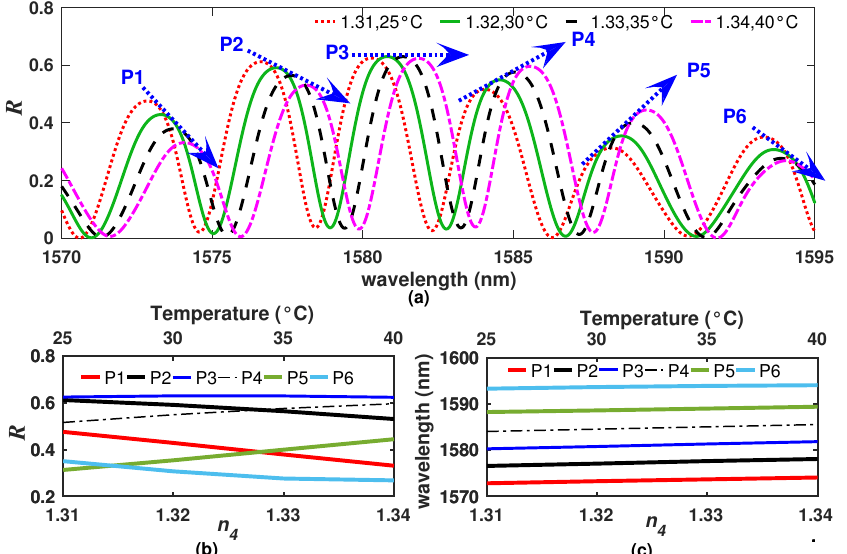
Figure 4. ( a ) Detail of the simulated R spectrum considering different n 4 and T values; ( b ) peak amplitude and ( c ) peak positions of the fringes P1 to P6 as n 4 and T are